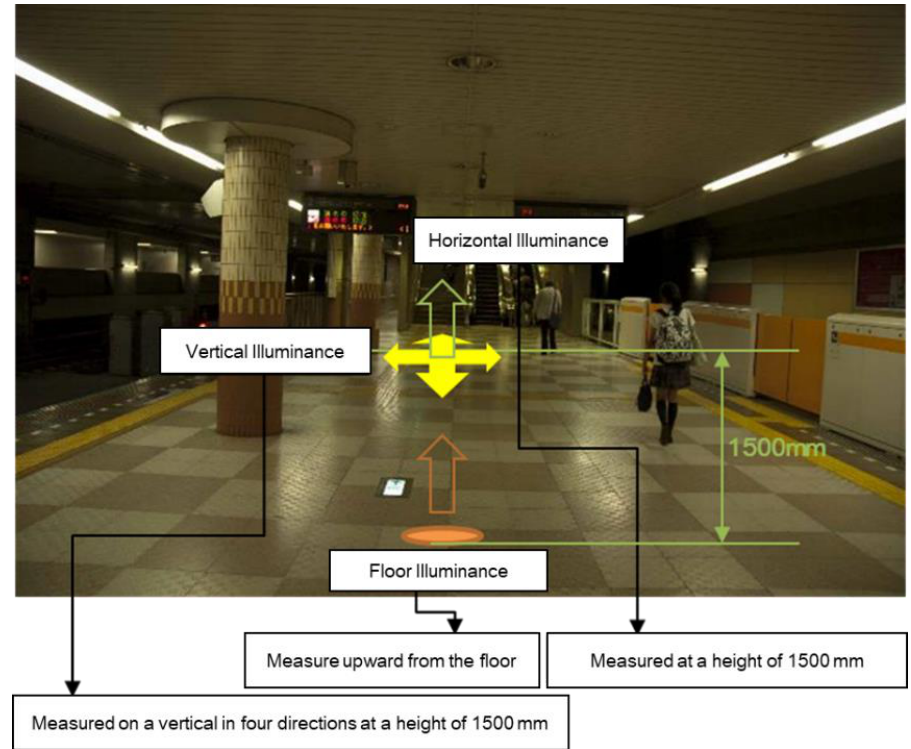
Figure 2. Examples of physical quantity measurement items.